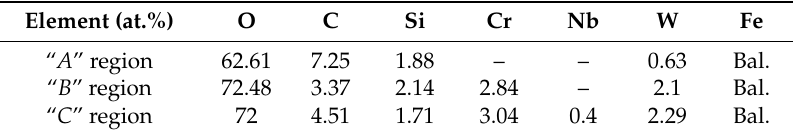
Figure 5. Cross-section worn morphologies of the coatings with load of 100 N. ( a ) Fe 65 P 5 Si 9 B 10 coating; Table 2. The compositions of worn surface.